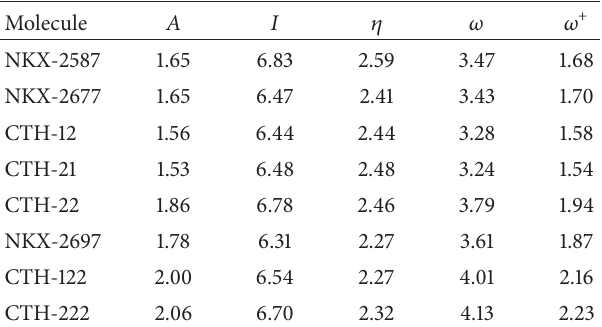
Table 2: Chemical reactivity of coumarin-derived dyes using the M06 functional combined with 6-311G(d) basis